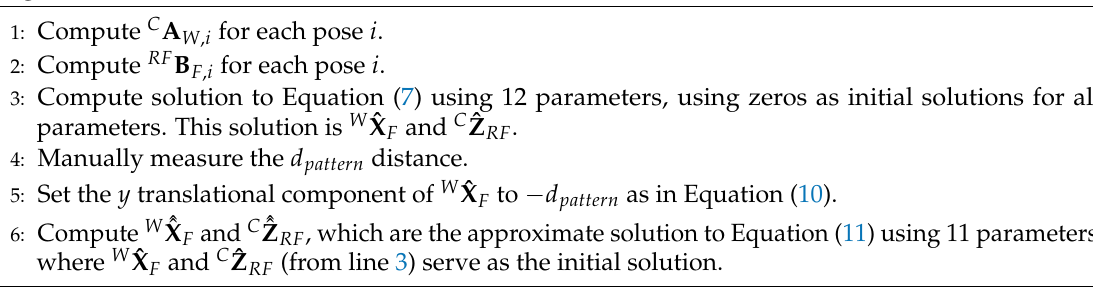
Algorithm 1 Perform calibration of two